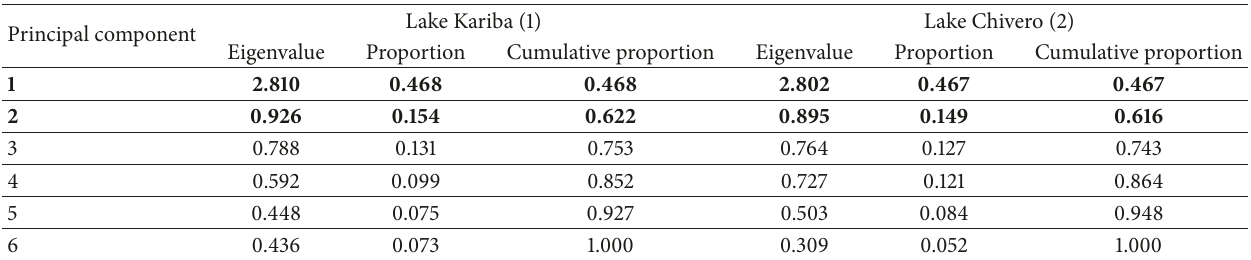
Table 5: Eigenvalues for the principal components of fish from Lake Chivero and Lake